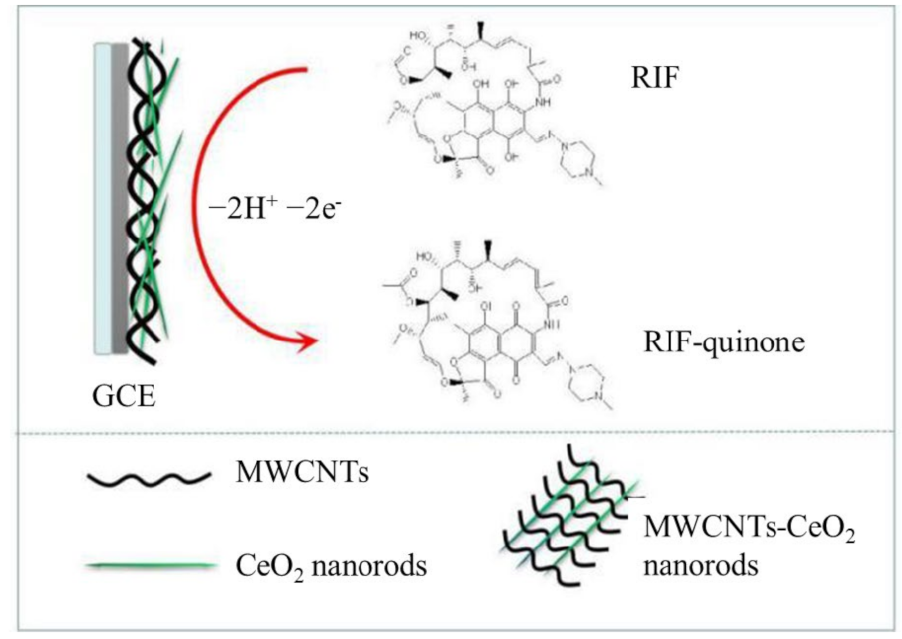
Figure 4. The scheme of the “nanonetwork” modified electrode and RIF electrooxidation at its surface